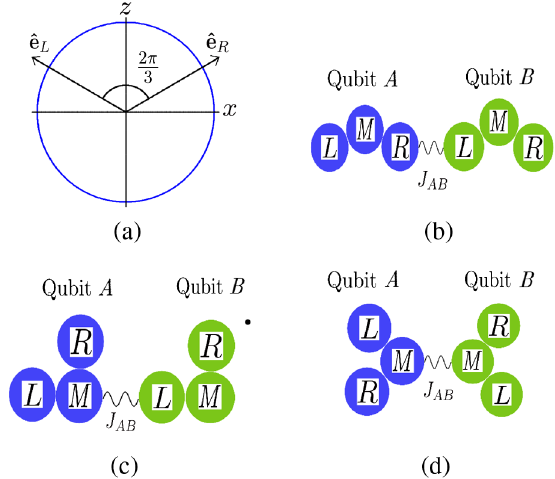
FIG. 1 (color online). (a) Bloch sphere of the exchange-only qubit. ˆ e L and ˆ e R are unit vectors for the left and right rotation axes. They are eigenvectors of the Hamiltonian of Eq. (1) with t ¼ 0 and t ¼ 0 , respectively. (b) R - L geometry: Nearest- L R neighbor capacitive interaction between the right dot of qubit A and the left dot of qubit B . (c) M - L geometry: Coupling be- tween the middle dot of qubit A and the left dot of qubit B . (d) M - M geometry: Coupling between the middle dots of qubits A and B . Blue and green dots represent qubits A and B , respec- tively. J AB is the interqubit coupling